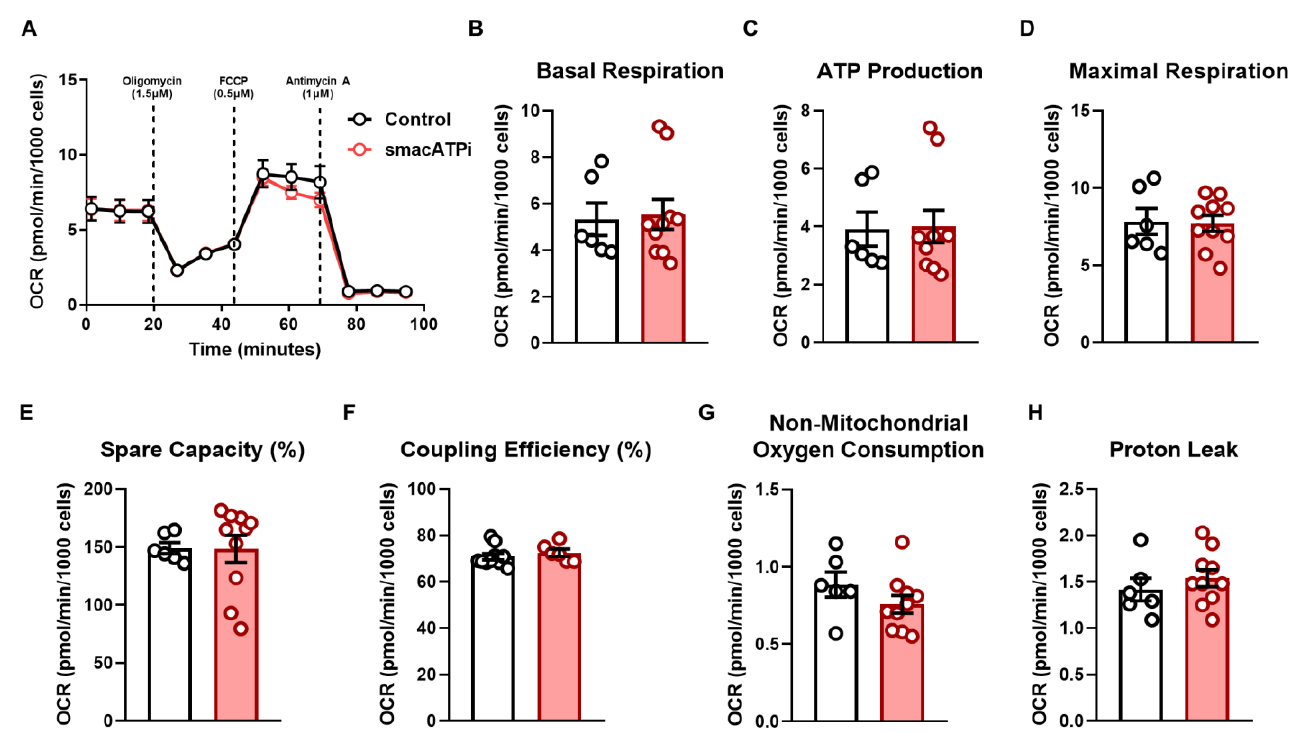
Figure 2. The expression of smacATPi does not interfere with cellular respiration. ( A ) Cellular bioenergetics was assessed in HEK293T cells with smacATPi expression. The oxygen consumption rate (OCR) of the cells transfected with smacATPi showed no change compared to non-transfected cells, indicating no adverse effects of smacATPi on cellular metabolism. ( A ) Overall OCR in response to inhibitors of oxidative phosphorylation. ( B ) Basal respiration (OCR) rate. ( C ) ATP-linked respiration (ATP production rate). ( D ) Maximal respiration. ( E ) Spare respiratory capacity. ( F ) Coupling efficiency. ( G ) Non-mitochondrial oxygen consumption. ( H ) Proton leak respiration. No change of the above parameters between the non-transfected HEK293T cells and those transfected with smacATPi could be detected ( n > 6; error bars are